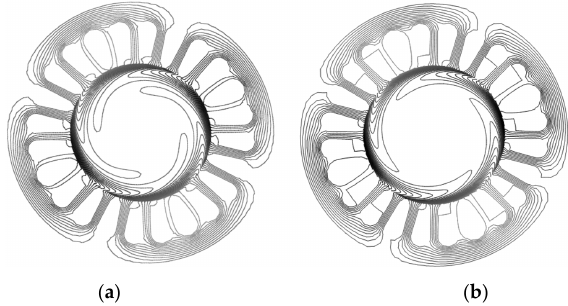
Figure 3. Comparison of sample distributions of magnetic flux over cross section of the motor at rotor slip equal to 10%: ( a ) time-domain model, ( b ) multi-harmonic model with all harmonics considered